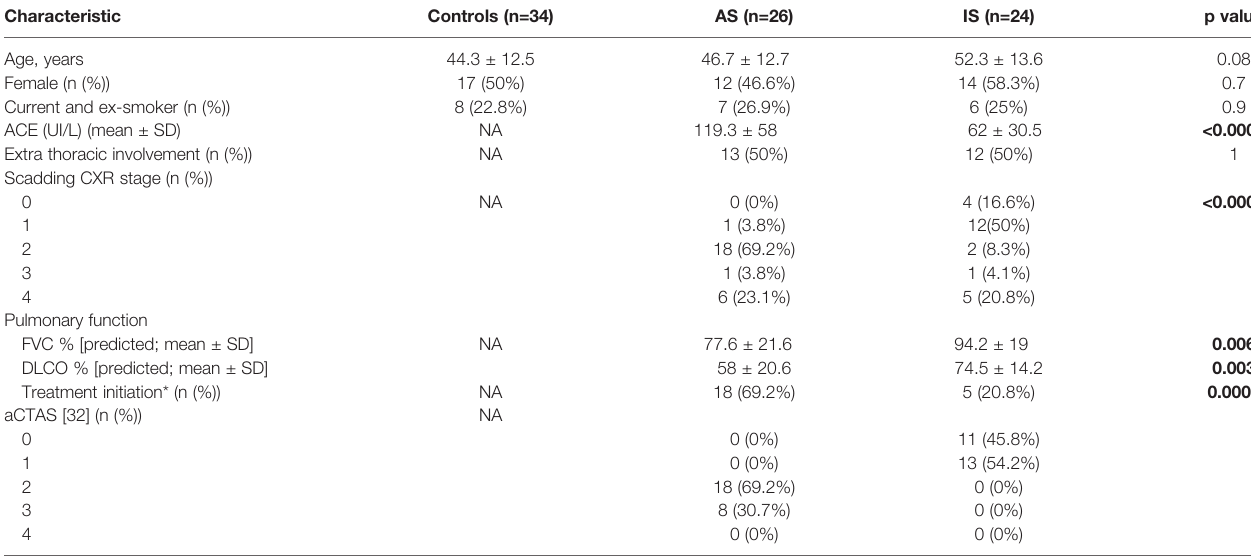
TABLE 1 | Subject characteristics.